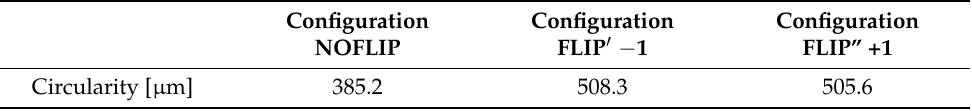
Figure 16. Polar graphs from measuring a circle on the plane parallel to the base of the robot. ( a ) NOFLIP configuration; ( b ) FLIP’ − 1 configuration (J4 = − 180 ◦ , R = 180 ◦ ); ( c ) FLIP’ +1 configuration (J4 = 180 ◦ , R = 180 ◦ ). Table 7. Average circularity value for measuring a circle on the plane parallel to the base of the